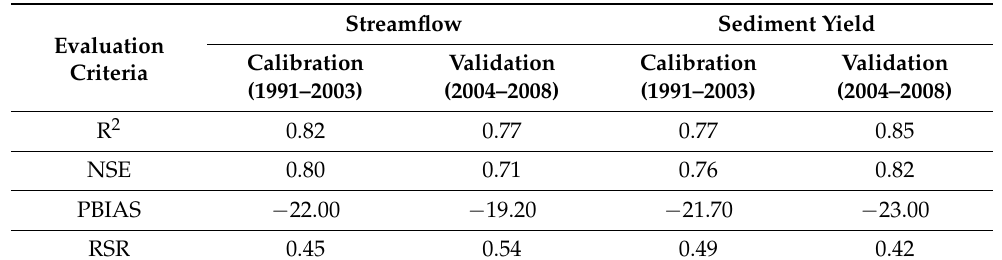
Table 5. The streamflow and sediment yield calibration and validation results.